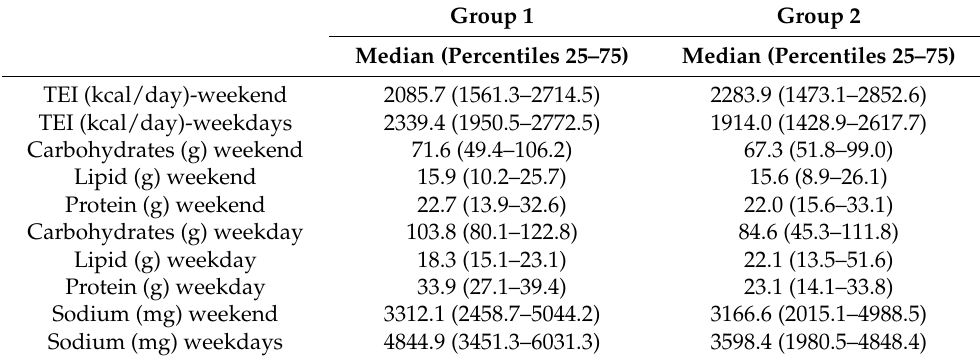
Table 4. Comparison of energy intake and nutrients from the weekend and